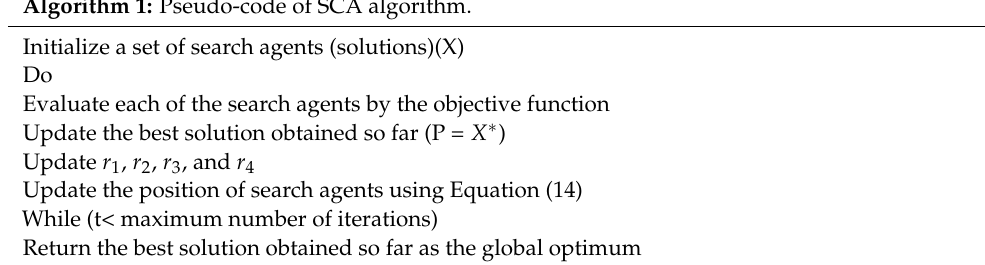
Algorithm 1: Pseudo-code of SCA